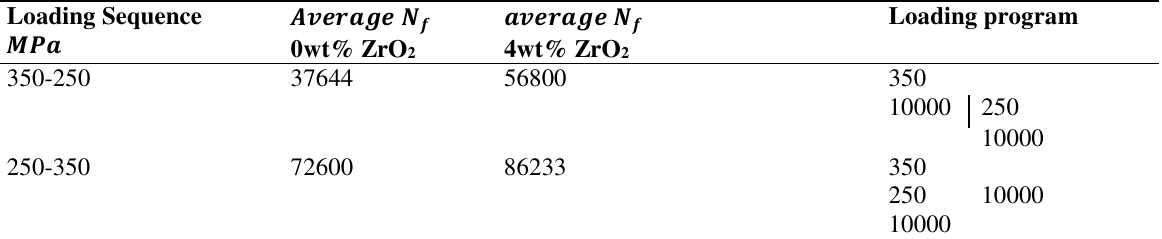
Experimental fatigue test under variable loading for base metal with 0wt% ZrO 2 and Nano composite 4 (cid:11) (cid:20) %ZrO 2 Loading